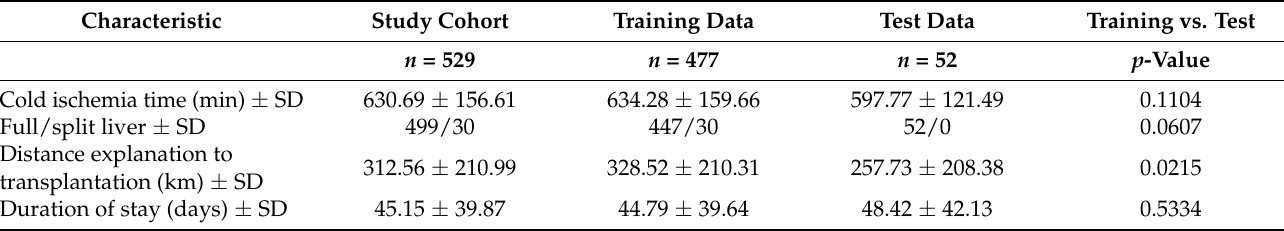
Table 2. Study data regarding variables during